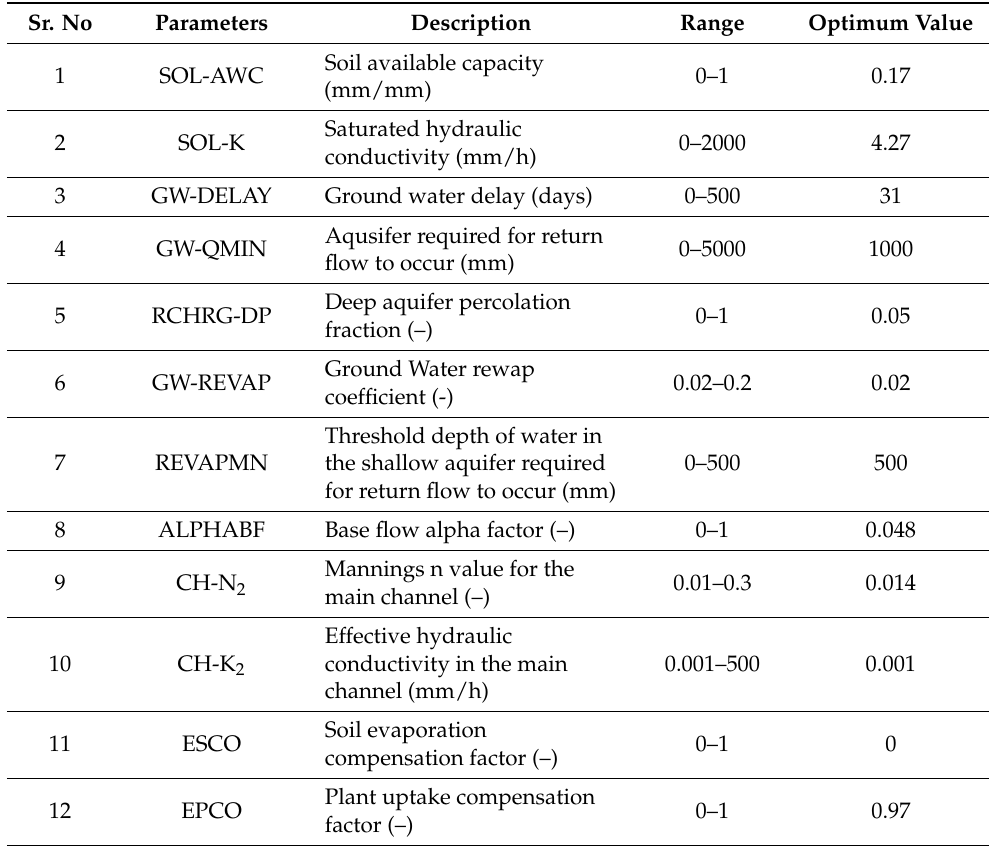
Figure 10. Profiles of simulated and observed runoff (monthly basis) at the SRB throughout ( a ) cal- ibration period, and ( b ) validation period.